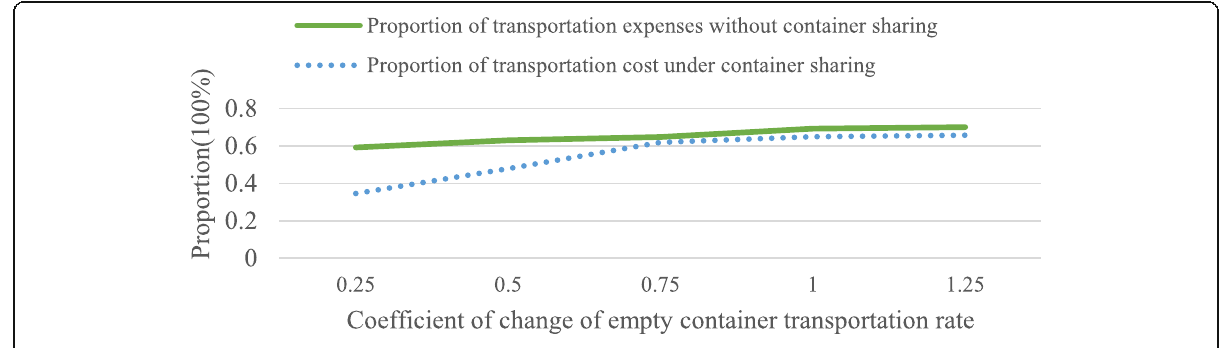
Fig. 5 Impact of empty container transportation rate change on the proportion of transportation